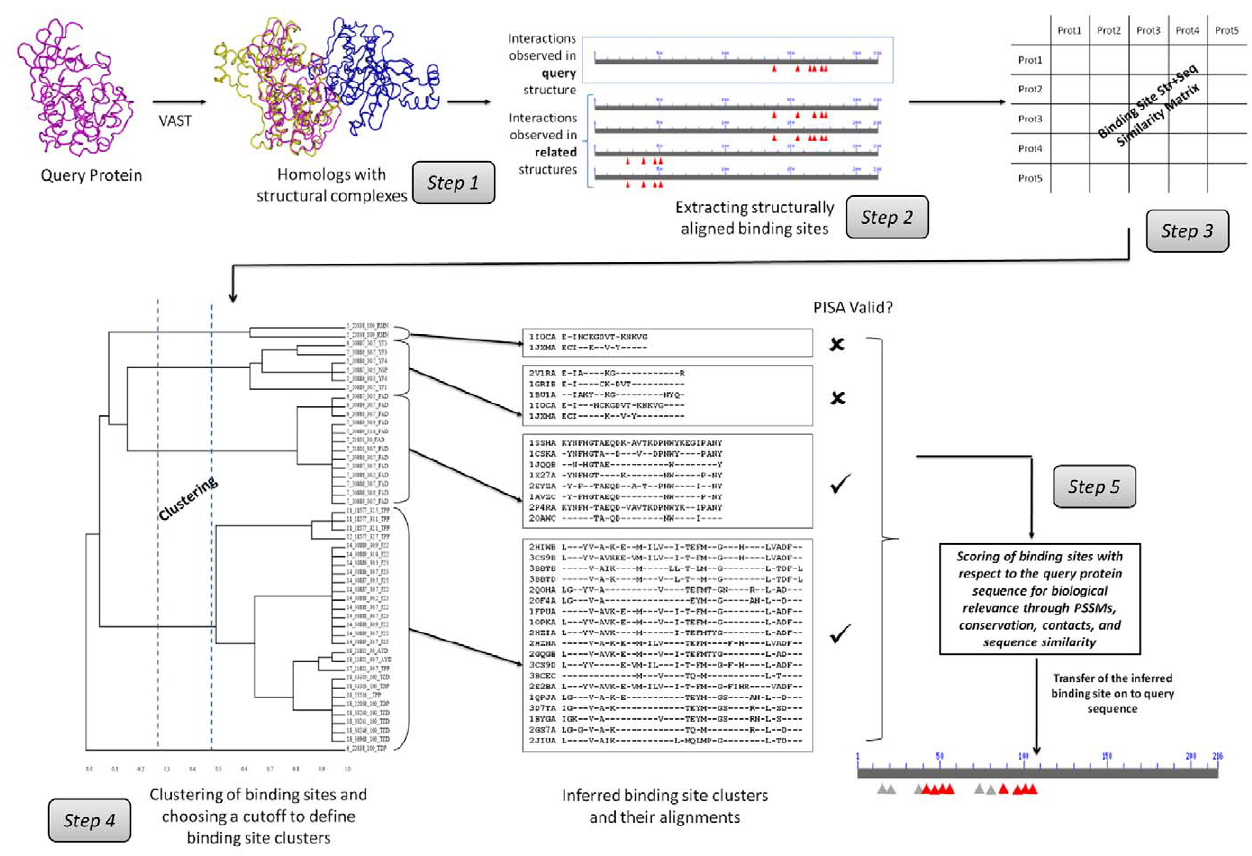
Figure 1. Overview of IBIS.